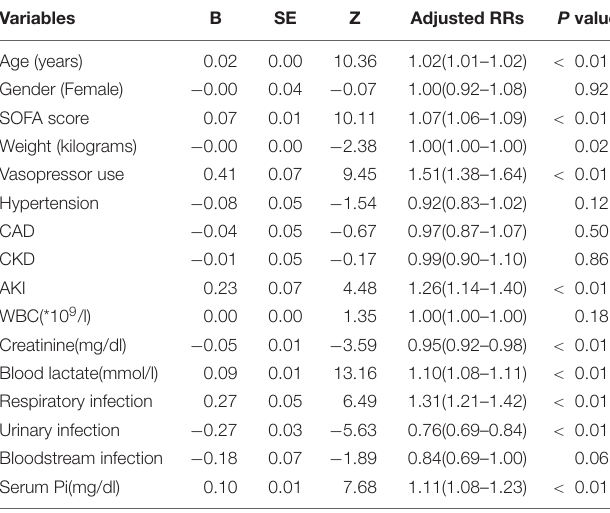
TABLE 3 | Results of log-binomial model analysis.